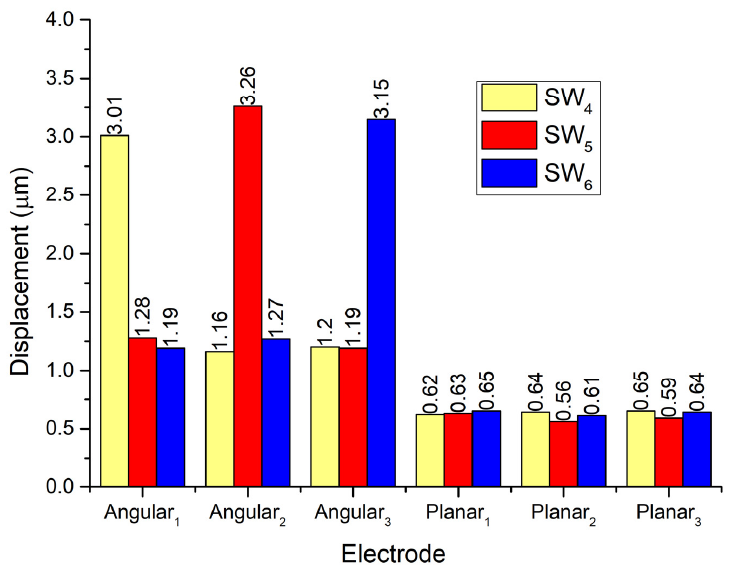
Figure 10. Comparison of displacement amplitudes while electrodes Angular 1 –Angular 3 excited by excitation signal consistently.